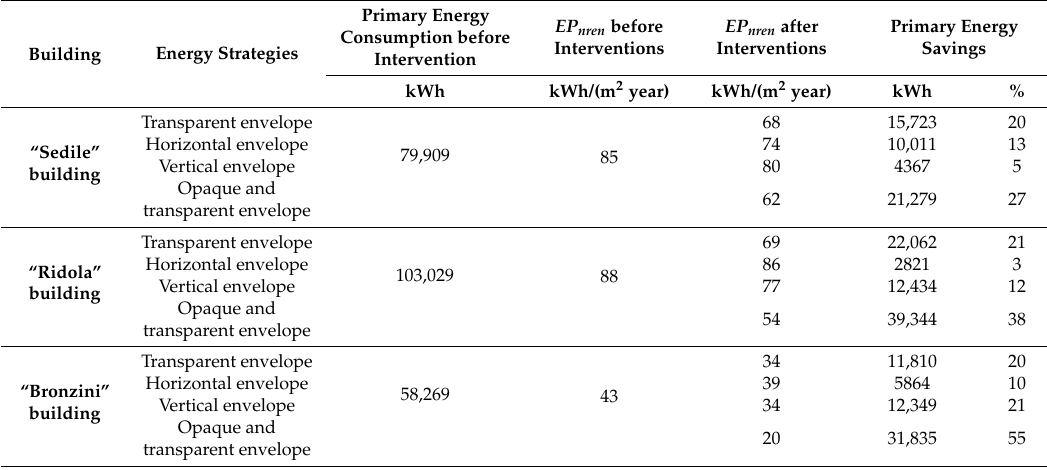
Table 10. Energy savings of the